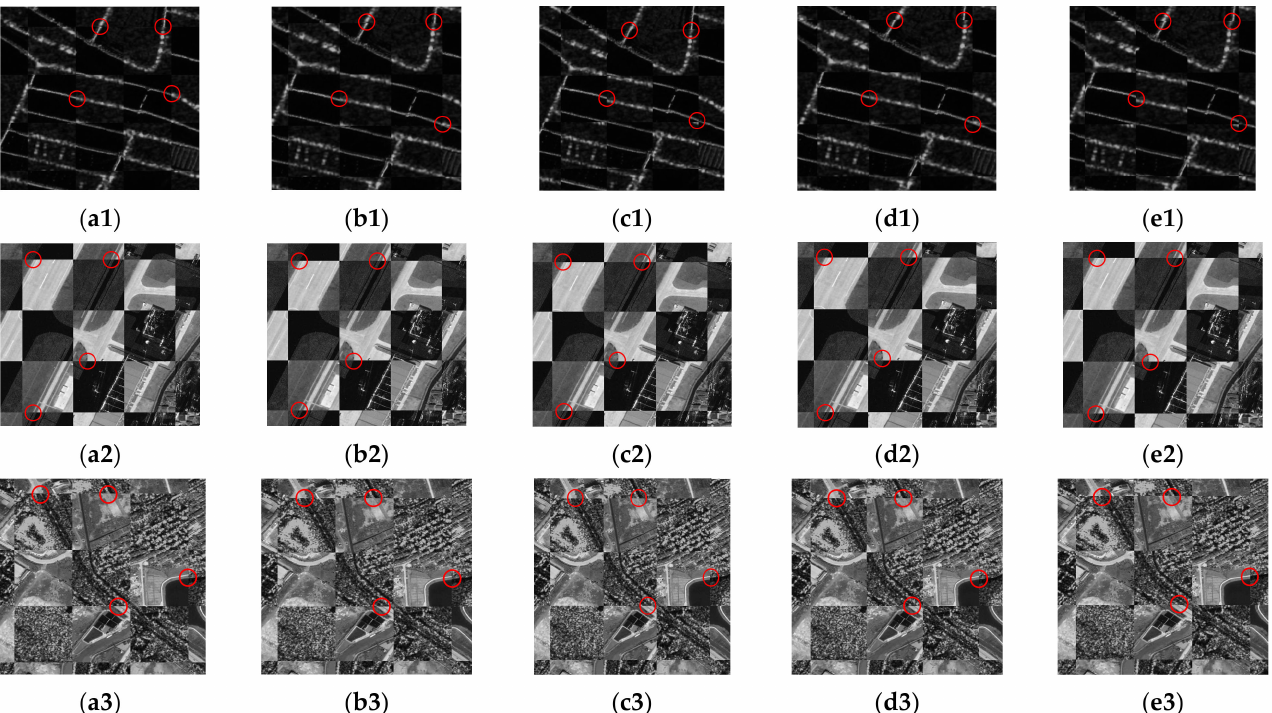
Figure 13. Mosaic map of registration results: ( a1 – a3 ) SAR-Harris. ( b1 – b3 ) UND-Harris. ( c1 – c3 ) Har- DoG. ( d1 – d3 ) Har-Lap. ( e1 – e3 ) DoG. The red circle in the figure represents the stitching details of the